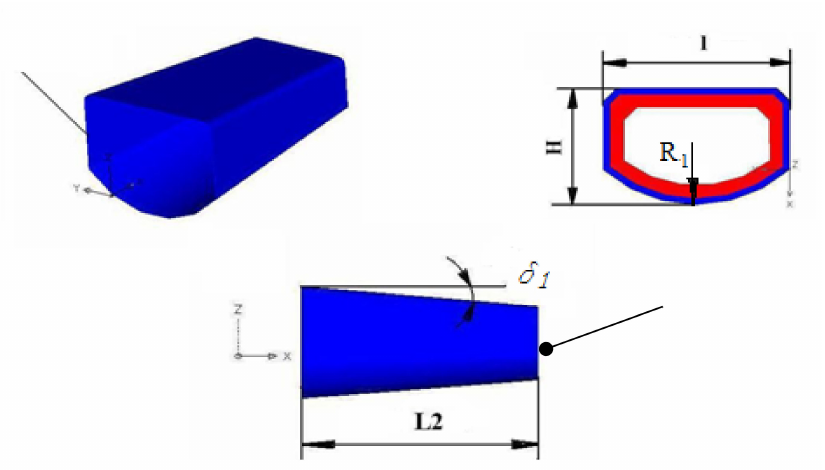
Figure 6. The central fuselage—Part